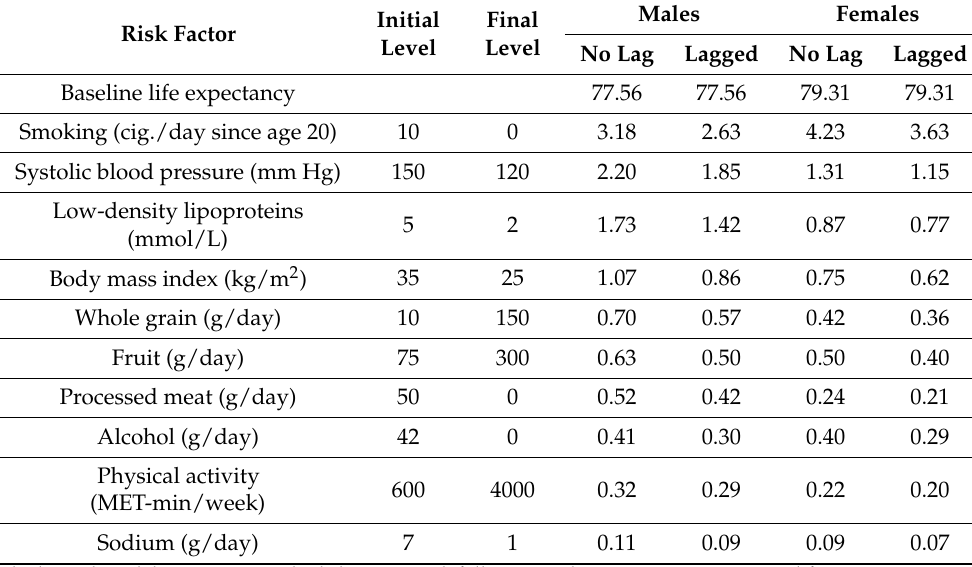
Table 5. An example of gains in LE50 for males and females 50 years of age with 10 risk factors, resulting from a reduction in exposure to each factor individually, according to a no-lag and lagged model, adjusted for mediation.